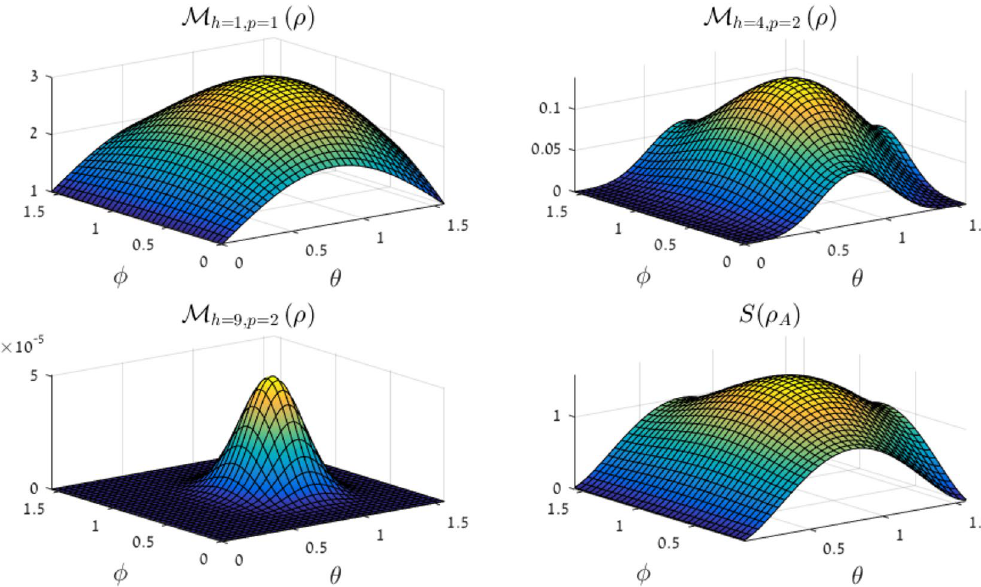
Figure 1. Several CMNs M h , p and the von-Neumann entanglement entropy S (ρ A ) , plotted for the two-qutrit states with pure-state-Schmidt coefficients given in spherical coordinates: s 1 cos θ (to avoid repetition, only the domain 0 s 3 = 0, π/ 2 , alludes to the domain where the state’s Schmidt rank is 1, and the same goes for M θ = M 3 2 , p also tells us where the Schmidt rank is 2, i.e., φ = 0, π/ 2 . (This figure was created using MATLAB h =